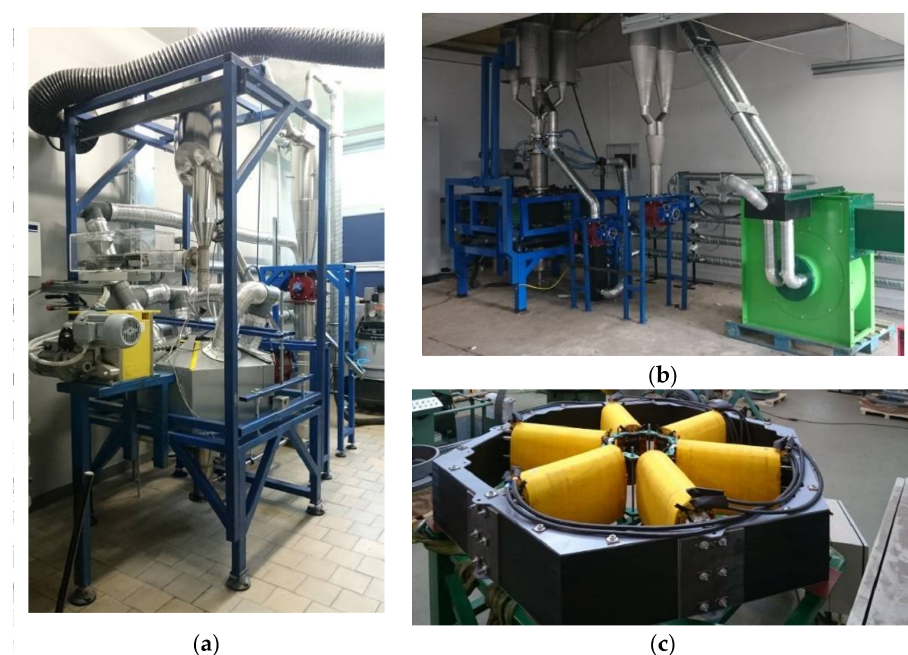
Figure 2. Examples of electromagnetic milling system: ( a ) diameter of the working chamber 100 mm;